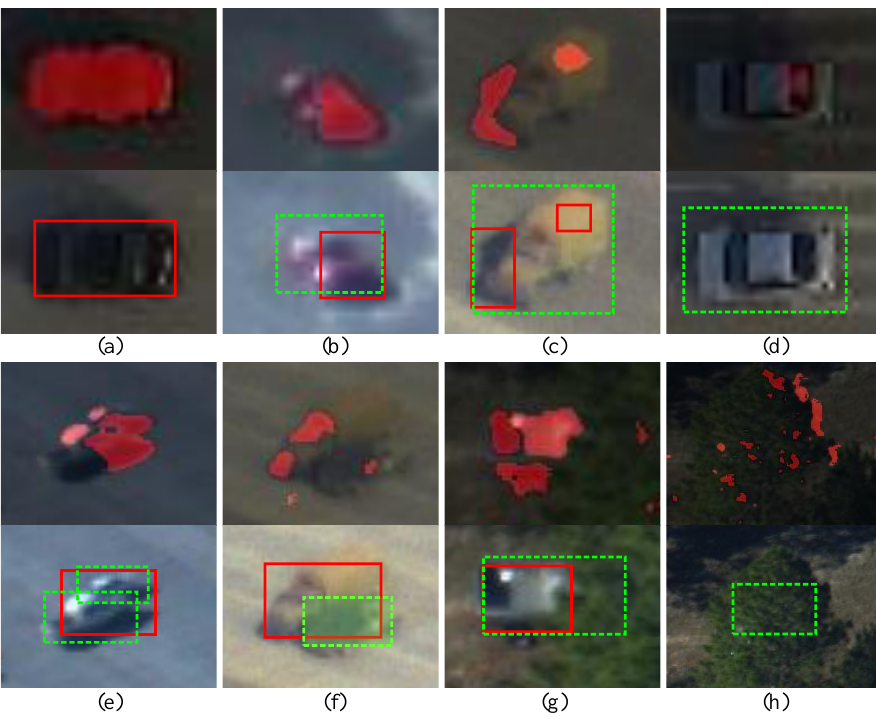
Figure 3. Motion compensation-based detection. Red blobs correspond to detected moving objects. Red bounding-boxes are the detection results, and green dotted boxes are ground truth. ( a ) good detection. ( b , c ) partially detected object. ( d ) not detected object. ( e ) occluded object. ( f ) unreliable detection. ( g ) partially detected object. ( h ) occluded